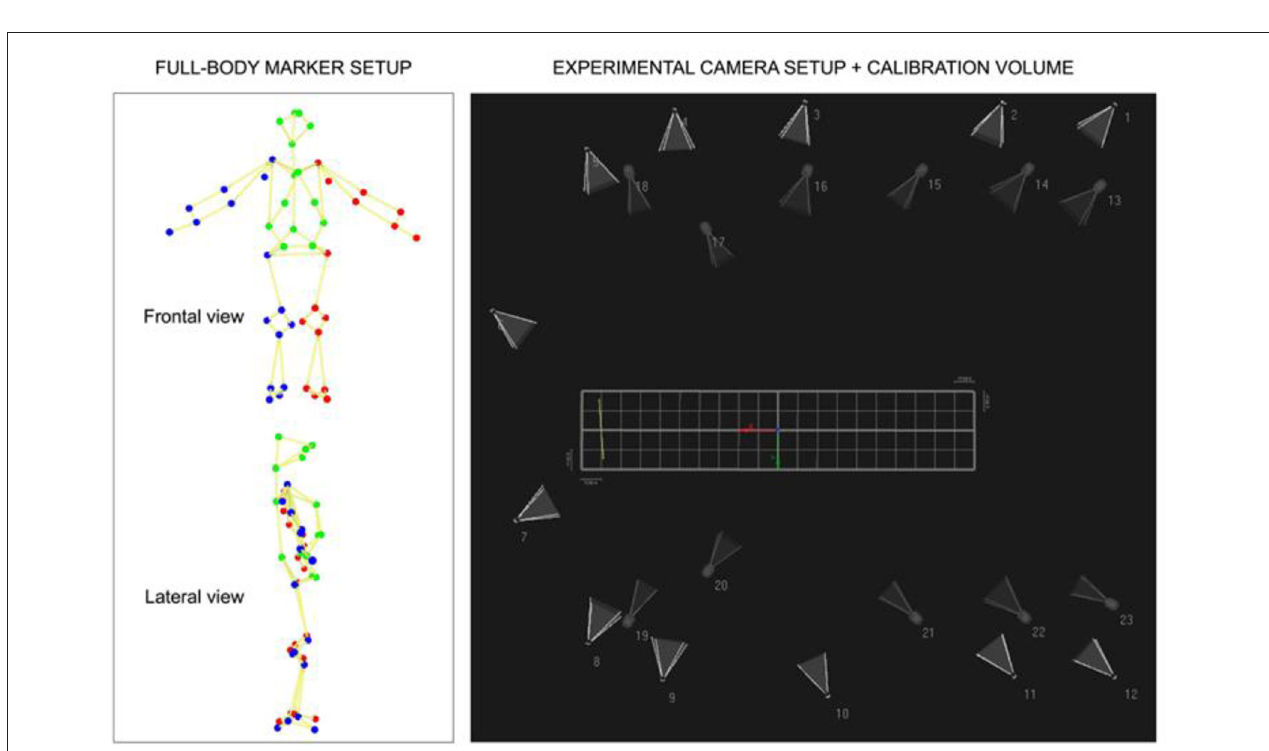
FIGURE 2 | Configuration of kinematic-temporal data: full-body marker setup in Qualisys Track, experimental camera positioning with 12 land and 11 underwater cameras, and calibration volume covered. The orthogonal axes were defined as X , Y , and Z for horizontal, mediolateral, and vertical ( Z = 0 defines water surface) movements. The yellow line depicts the reference system and positioning of the triaxial two force